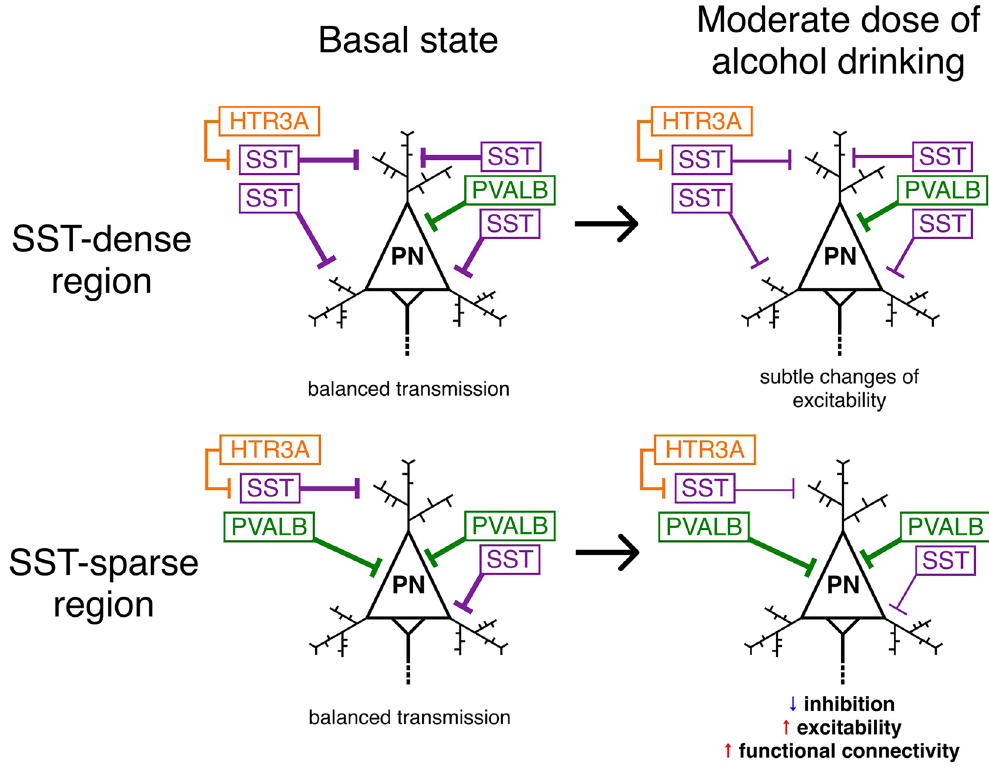
Figure 3. A proposed model of alcohol-induced changes in functional connectivity. In basal states, pyramidal neurons are inhibited by GABAergic interneurons, which leads to balanced transmissions. After drinking a moderate dose of alcohol, the activity of SST-expressing interneurons is disrupted, resulting in disinhibition, hyperexcitability, and increased functional connectivity only in SST-sparse regions. HTR3A 5-hydroxytryptamine 3a receptor, GABA gamma-aminobutyric acid, PN pyramidal neuron, PVALB parvalbumin, SST